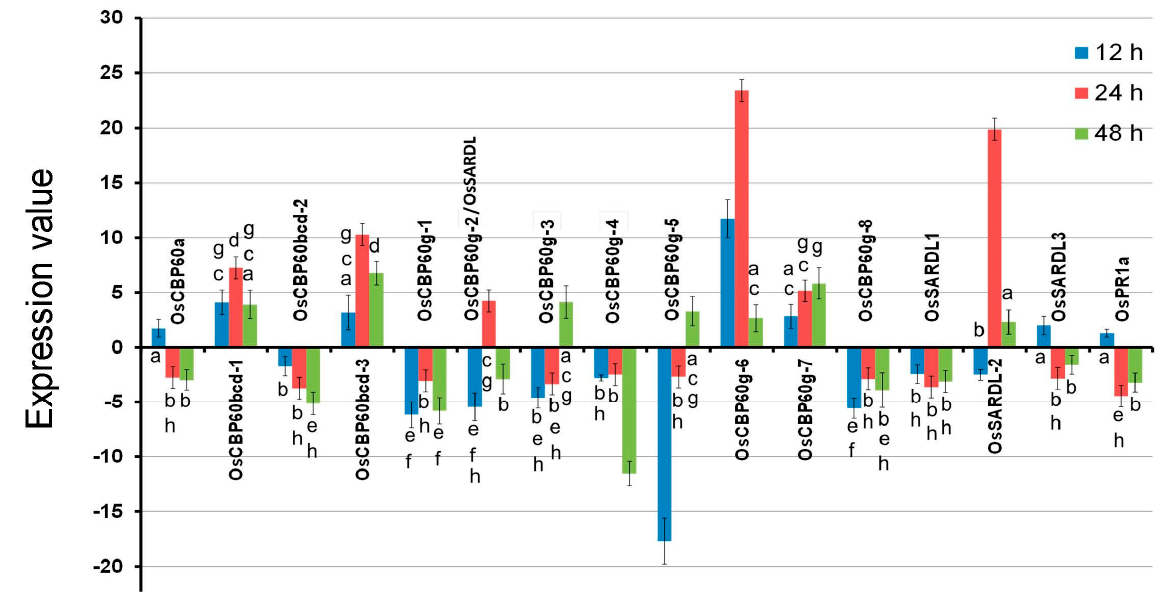
Figure 9. Transcriptional response of OsCBP60 genes in rice seedlings treated with jasmonic acid (JA). Rice seedlings were treated with 100 µM JA and transcript levels were analyzed by qRT-PCR at 12, 24 and 48 h post treatment. Relative transcript abundance (expression value) is expressed as fold-change relative to the mock treatment. OsPR1a was used as a control. Results are representative of three independent experiments. Error bars represent standard error (SE) of mean for three replicates. Superscripts with the same letter are not significantly different ( p < 0.05) by one-way ANOVA-protected LSD test.